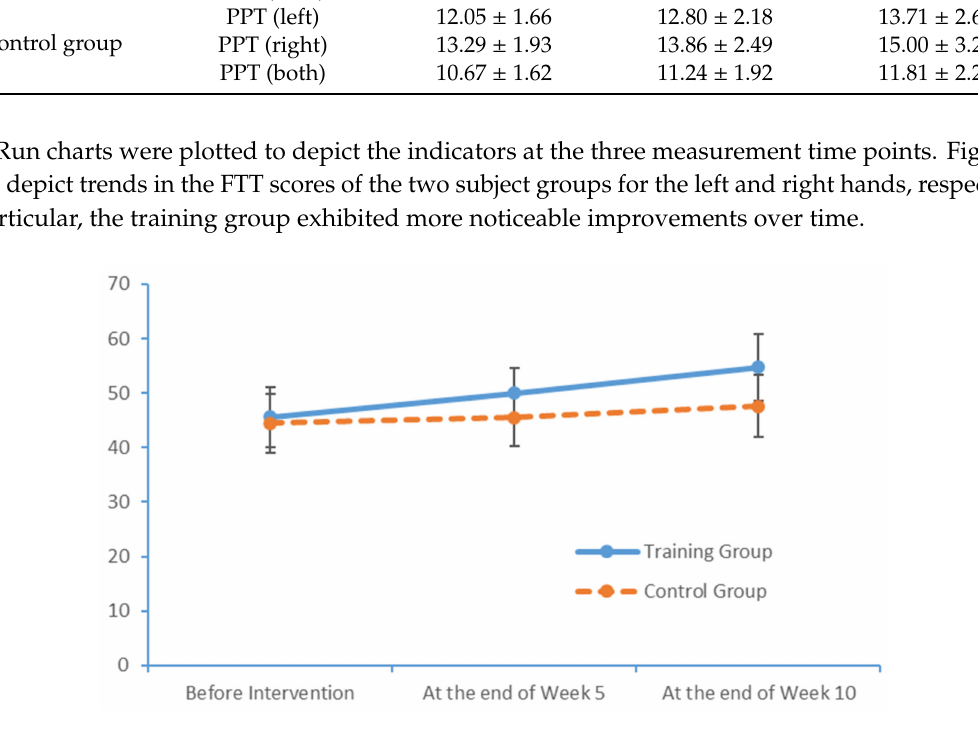
Figure 3. Changes in the left-hand FTT scores of the two groups at each time point.